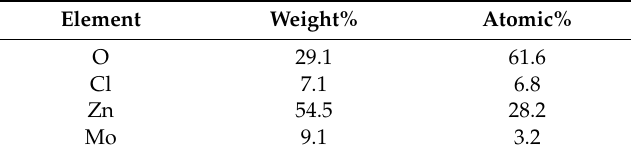
Table 1. Element proportion analysis of MoZnO.